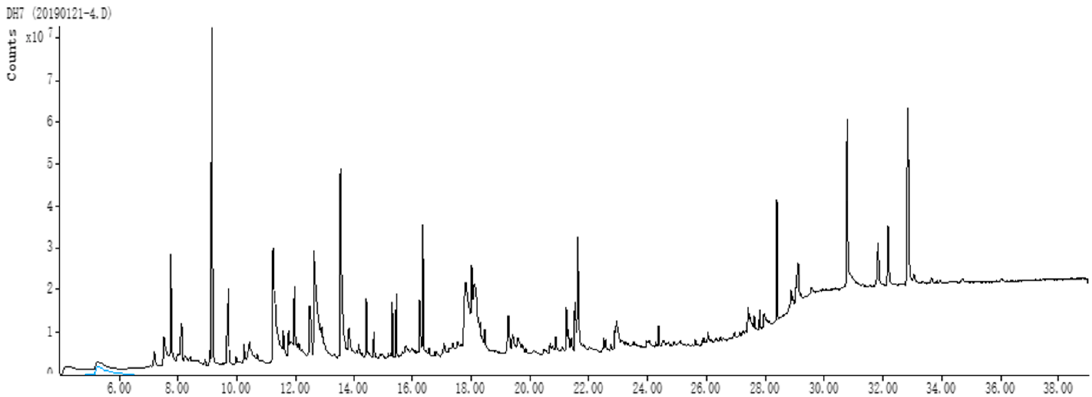
Figure 1. GC-MS analysis of the methanolic extract of dry lemon powder.